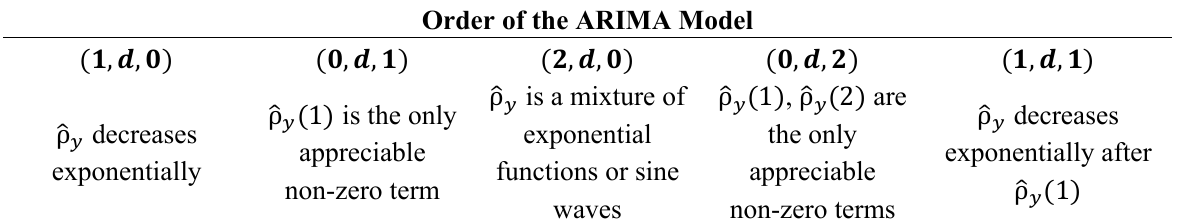
Table 1. Behavior of the sample autocorrelation function, ρ(cid:3548) ARIMA process of order (cid:4666)(cid:1868), (cid:1856), (cid:1869)(cid:4667) .